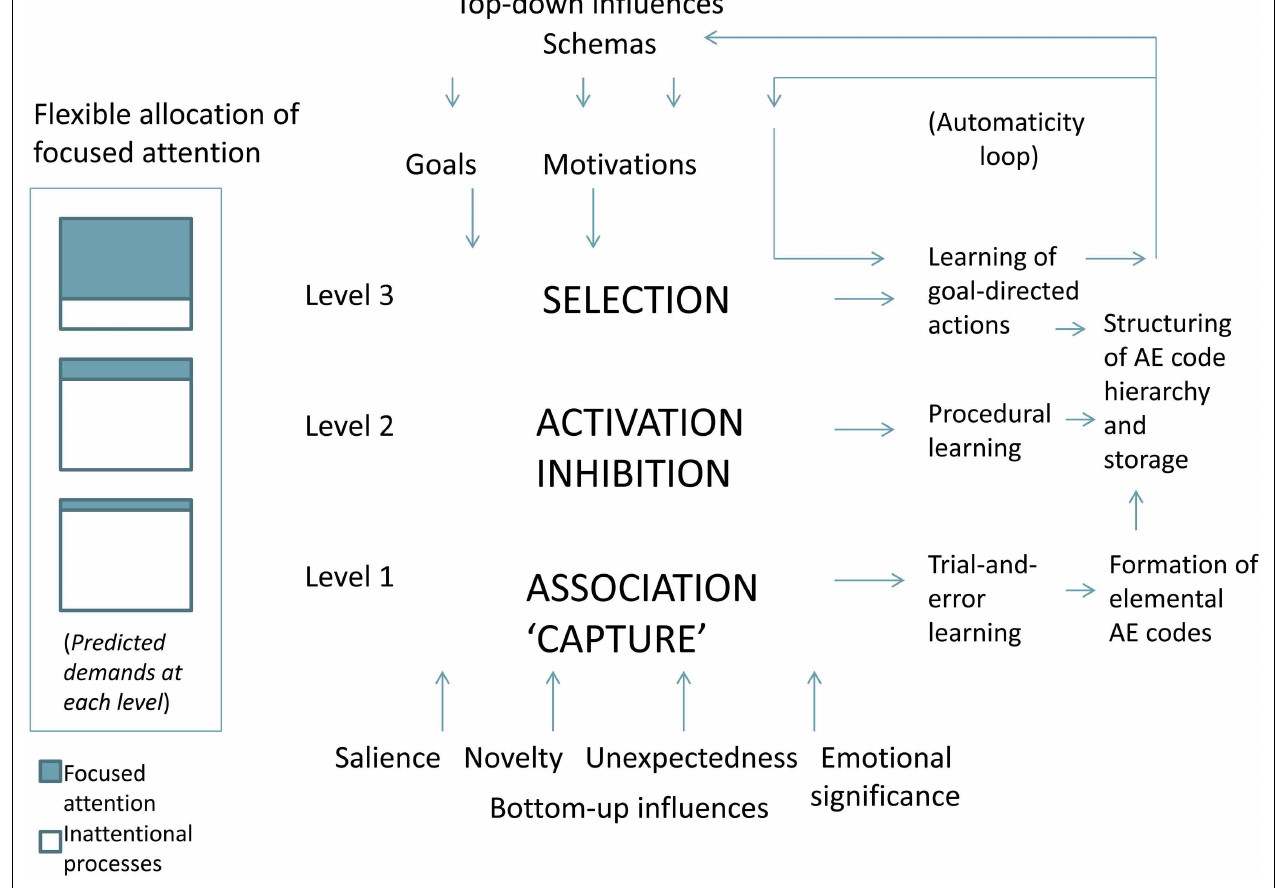
FIGURE 1 |The proposed framework underlying an allocation of attention system, presented in summarized form. Key processes are highlighted in bold caps at each of the three conceptualized levels of the system, and arrows indicate general direction of information flow, although all levels are highly interacting with many feedback projections not shown